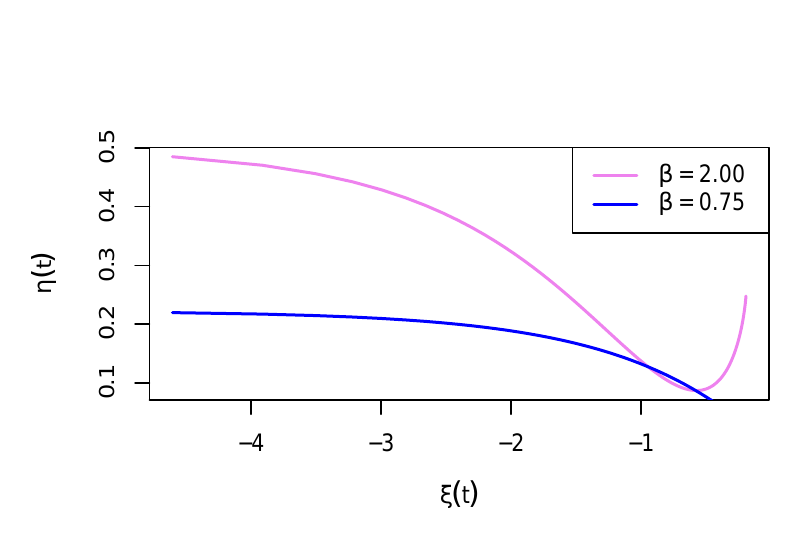
Figure 3 – Plot of η ( t ) against ξ ( t ) for Pareto I model with β =